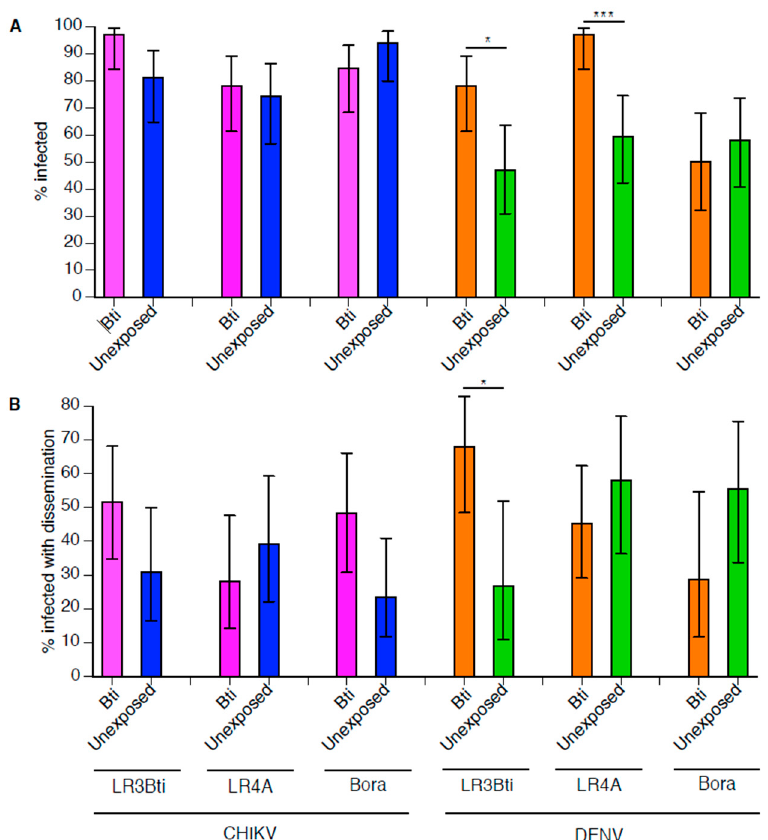
Figure 1. Arbovirus susceptibility following sub-lethal Bacillus thuringiensis subsp. israelensis ( Bti) exposure during larval development. For each arbovirus, the chikungunya virus (CHIKV) and the dengue virus (DENV), the percentage of infected mosquitoes ( A ) and the percentage of infected mosquitoes with a disseminated infection ( B ) are shown as a function of strain and treatment. Error bars represent 95% confidence intervals of the percentages. Stars above the bars indicate statistical significance of pairwise differences after Bonferroni correction for multiple testing (* p < 0.05; ** p < 0.01; *** p < 0.001). Test statistics for the full model are provided in Table 1.